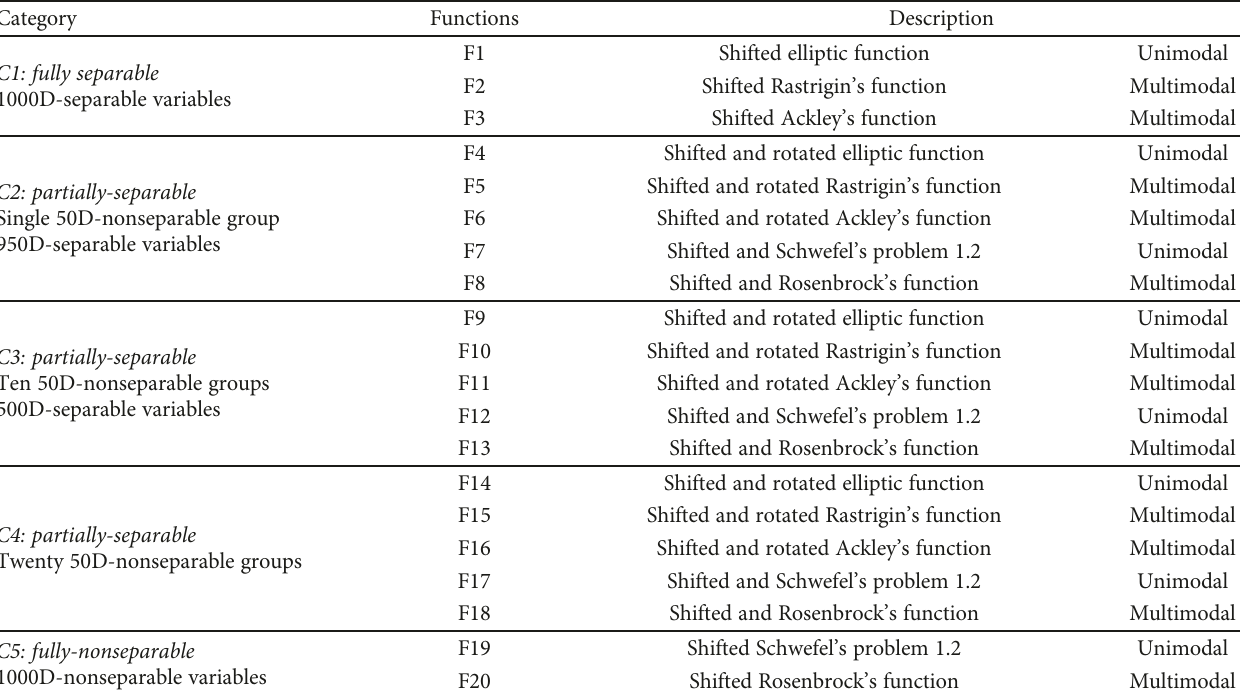
Table 1: Description of the CEC ’ 2010 benchmark